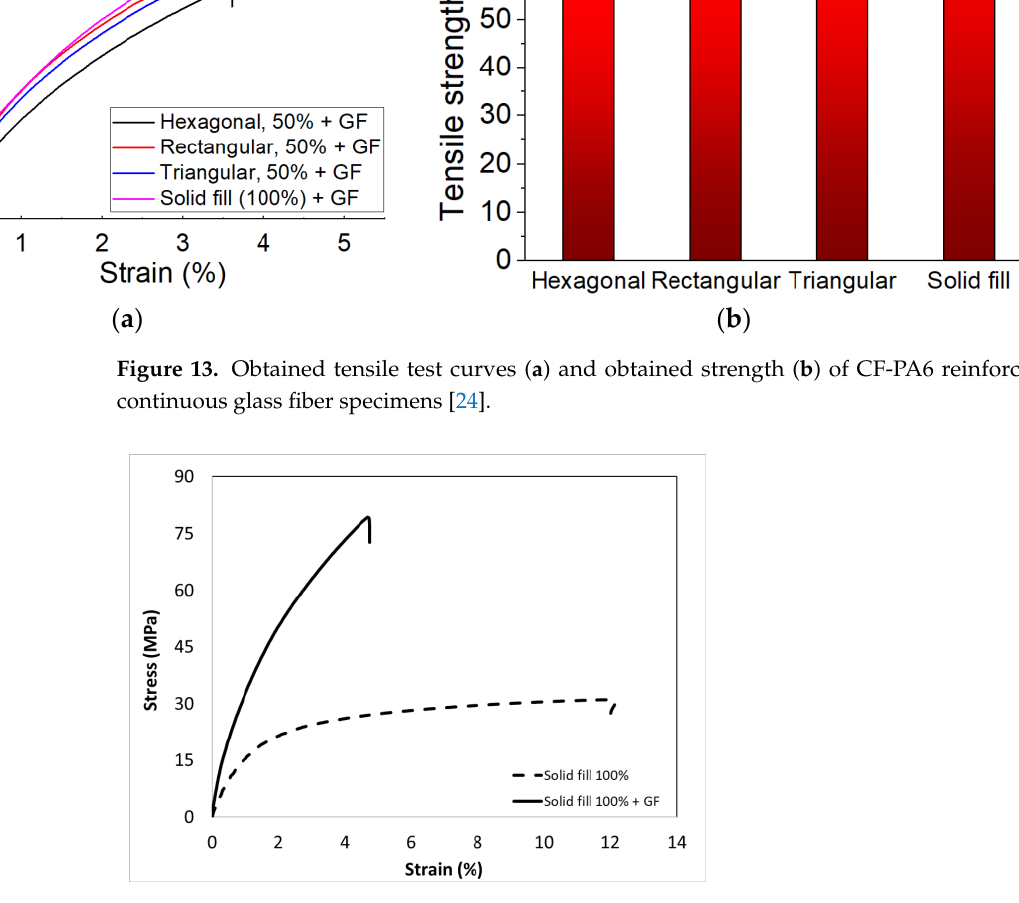
glass fiber (Onyx + GF) (solid fill pattern) [24].